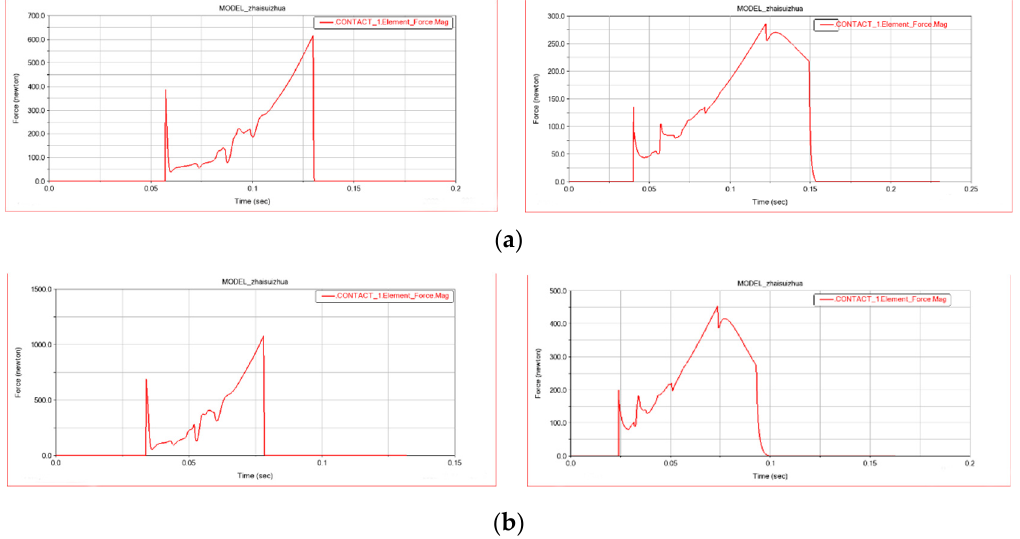
Figure 3. Contact force of ears at different claw picking speeds with a forward speed of 0.5 m/s. ( a ) Claw picking speed: 1.5 m/s; ( b ) claw picking speed: 2.5 m/s.